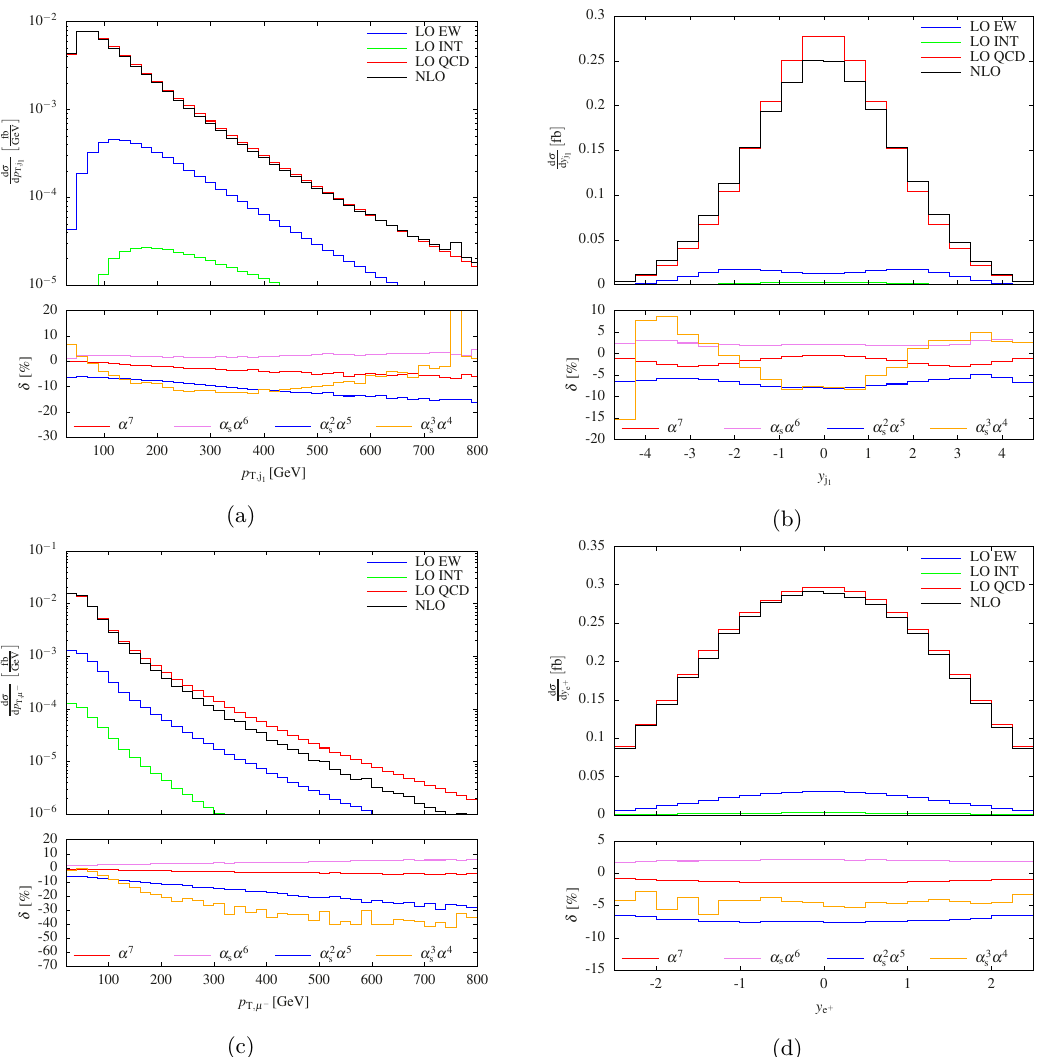
Figure 6 . Same as for figure 4 but for the observables: transverse momentum of the hardest jet (top left), rapidity of the hardest jet (top right), transverse momentum of the muon (bottom left), and rapidity of the positron (bottom